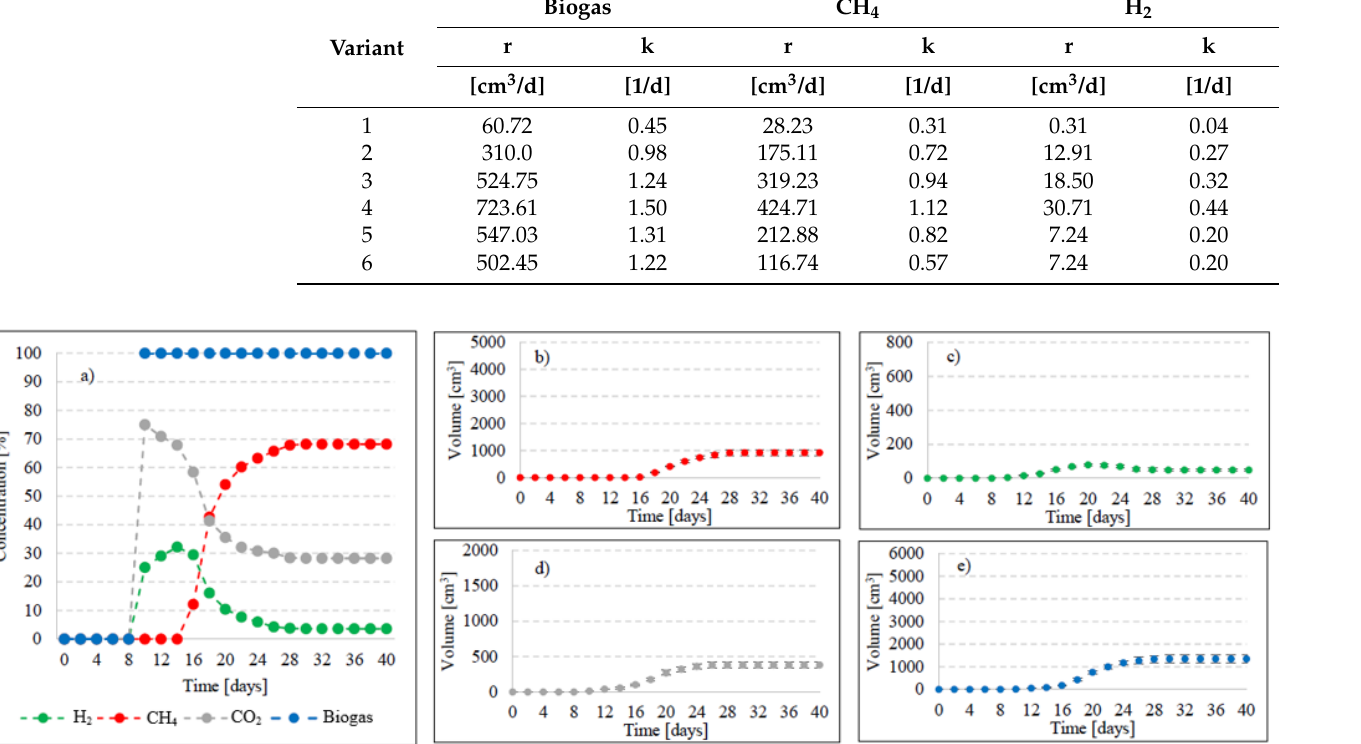
Figure 3. Changes in concentrations of biogas fractions in V1 ( a ); total volumes of CH 4 ( b ), H 2 ( c ), CO 2 ( d ), and biogas ( e ). Table 2. Yields of biogas and its major fractions in particular technological variants.